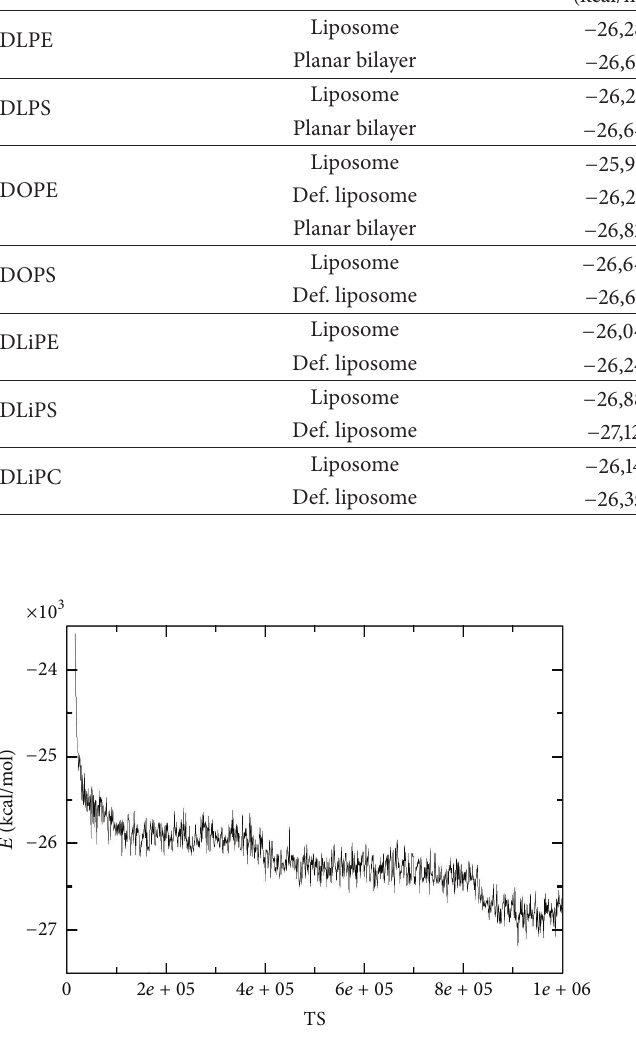
Table 1: Formation of aggregate structures of 256 phospholipid molecules during 160ns simulation. Phospholipid species